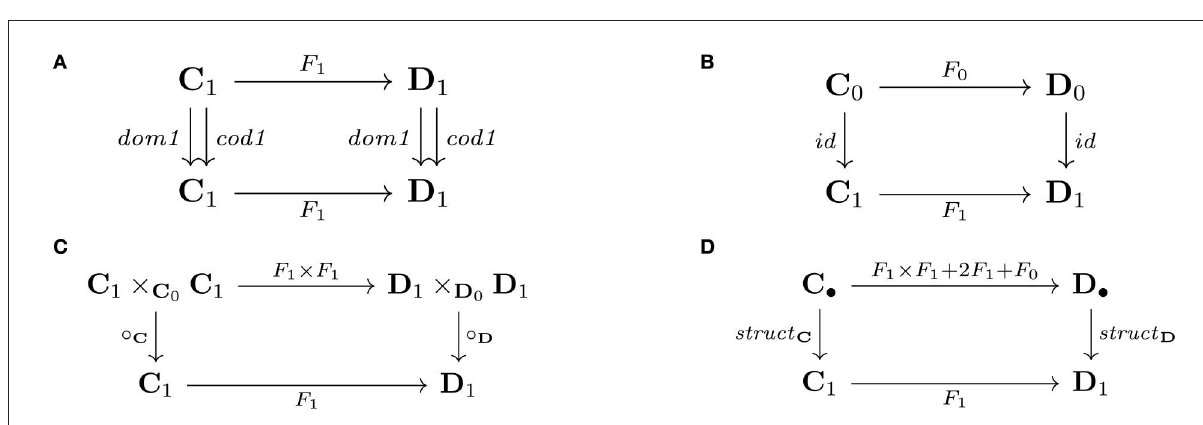
FIGURE7 Functors as commutative squares preserving (A) domains/codomains, (B) identities, and (C) compositions, that is, (D) category